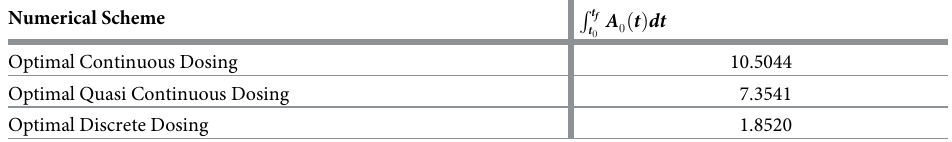
Table 1. Total antibiotic